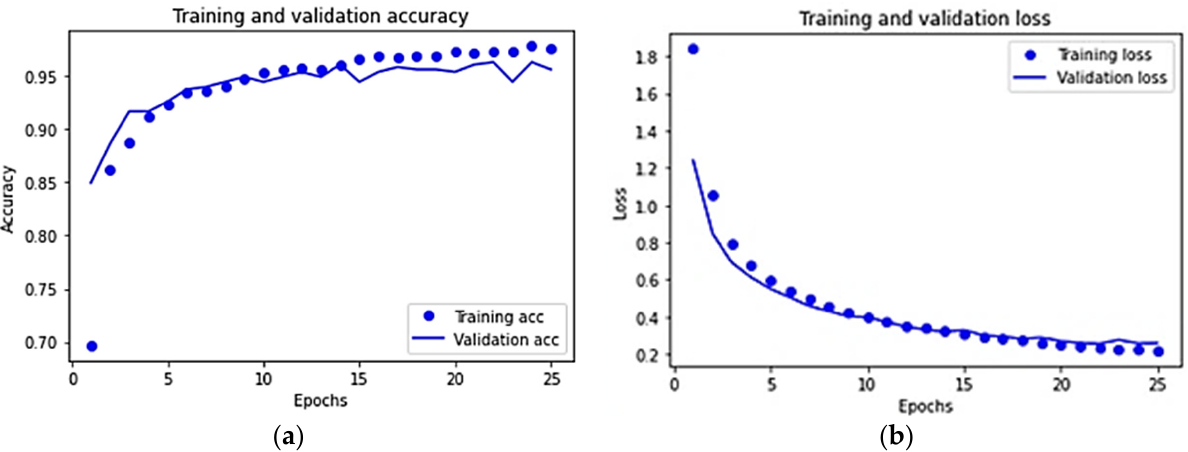
Figure 7. For the VGG16 pre-trained model: ( a ) training and validation accuracy, and ( b ) training Figure 6. For the proposed model: ( a ) training and validation accuracy, and ( b ) training and and validation loss. validation